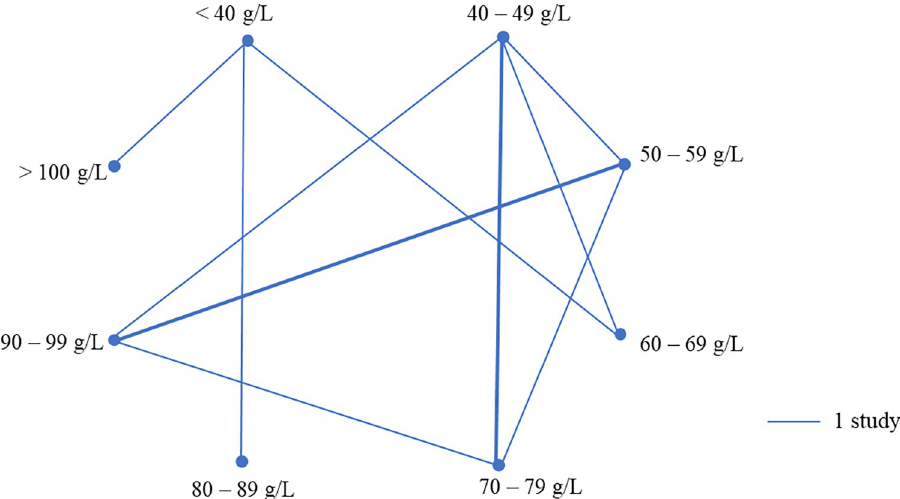
Fig 5. Schematic summary of the concentrations of IgG in colostrum in 24 controlled studies that compared colostral quality. Studies that targeted other risk factors as the main intervention (n = 10), wider range of colostral Ig concentration (n = 4), no information on colostral Ig concentration (n = 2) and fermented compared with unfermented colostrum (n = 1) were excluded. The thickness of lines represents the number of studies conducted between the combinations of treatment groups.